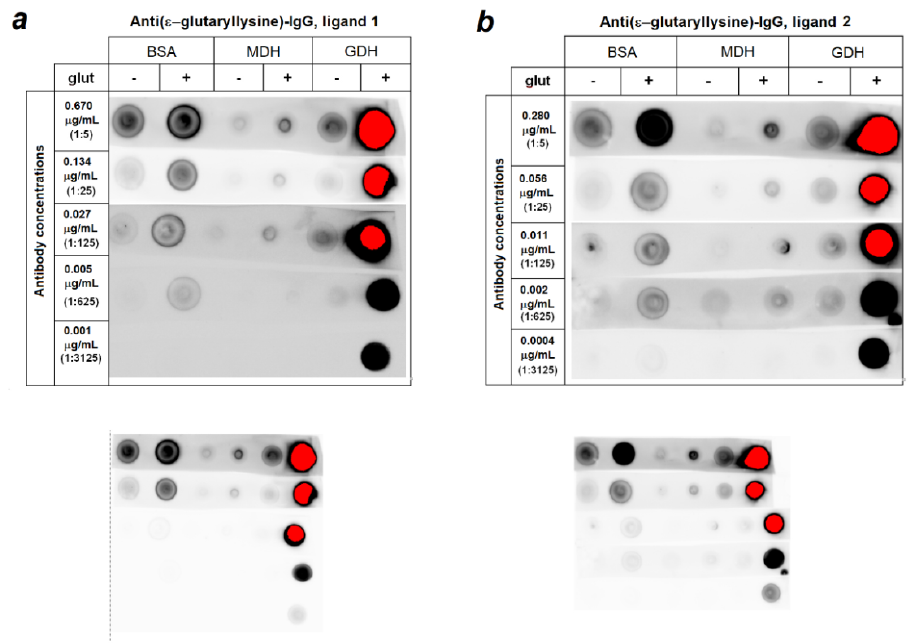
Figure 1. Immunodot titration results of affinity purified anti( ε -glutaryl-lysine) antibodies prepared from IgG fraction of antiserum obtained after the two immunization cycles. ( a )—Titration of the antibodies purified from the ligand-1-comprising matrix; ( b )—titration of antibodies purified from the ligand-2-comprising matrix. For better visualization of the results, different contrast was employed for the upper two and lower three rows. Lower figures present the visualization of all rows at the same brightness. Red-colored spots correspond to an extremely high luminescence.